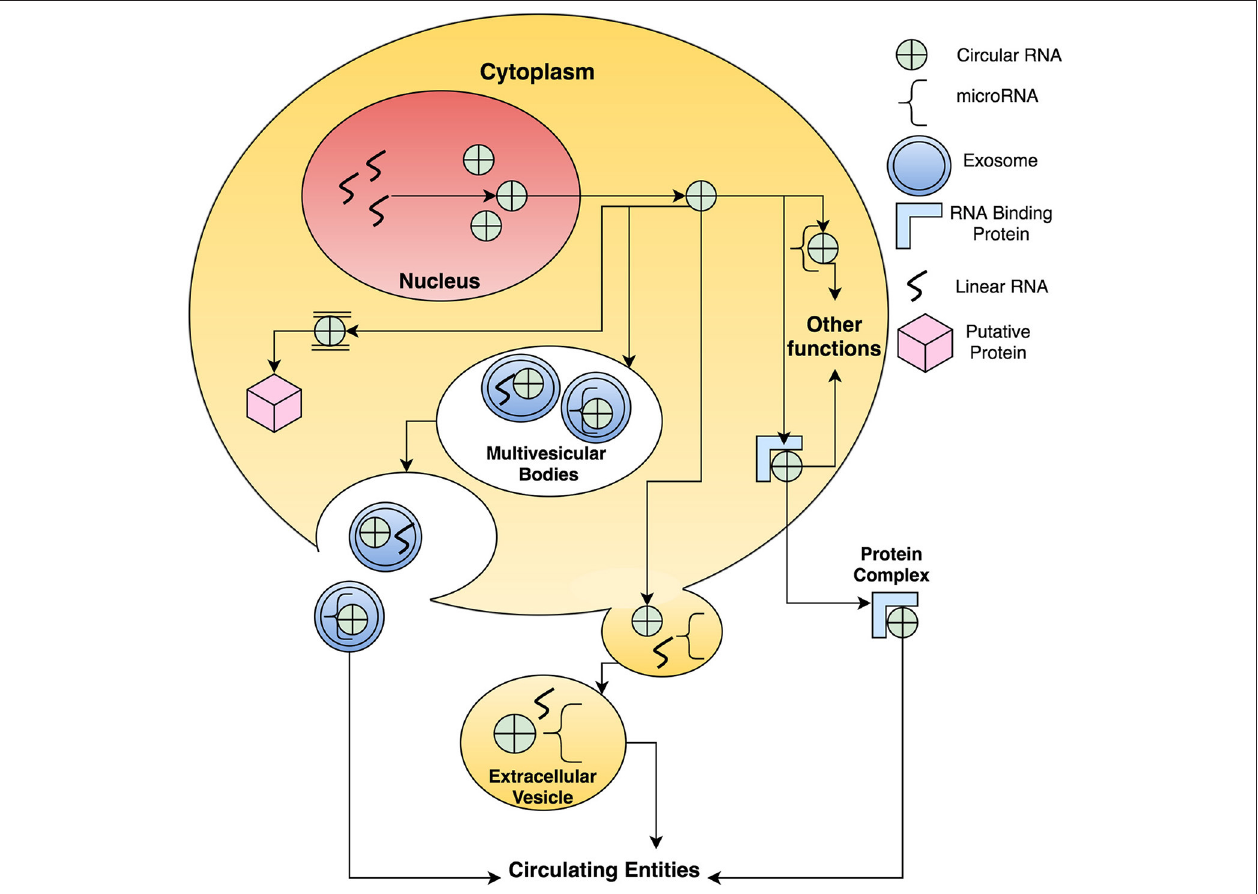
FIGURE 1 | A schematic proposition on how circular RNAs function and are transported around the cellular system. There are many possibilities to the function of circular RNAs such as sponging miRNA, binding to RNA binding proteins, being packaged into extracellular vesicles and exosomes and assisting in protein translation.